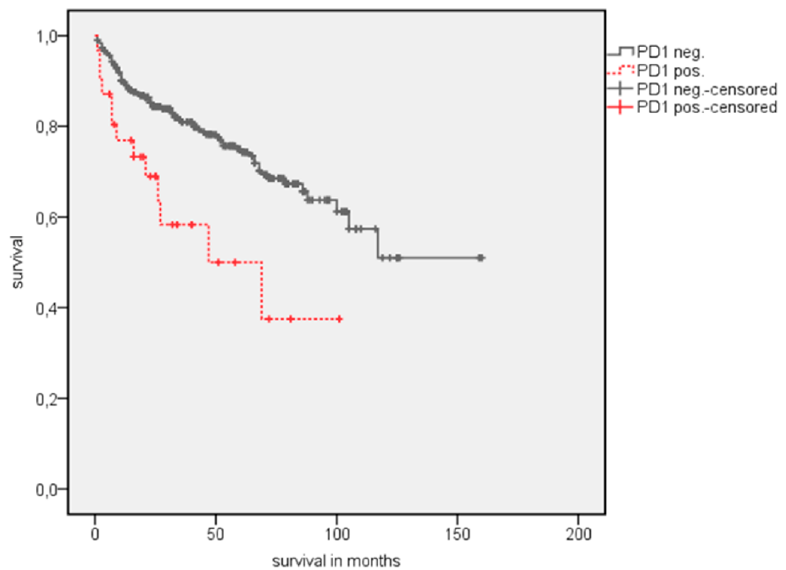
Figure 3. Kaplan Meier analysis: Association of PD1 expression in TIMC with cancer-specific survival (CSS) in all RCC patients.